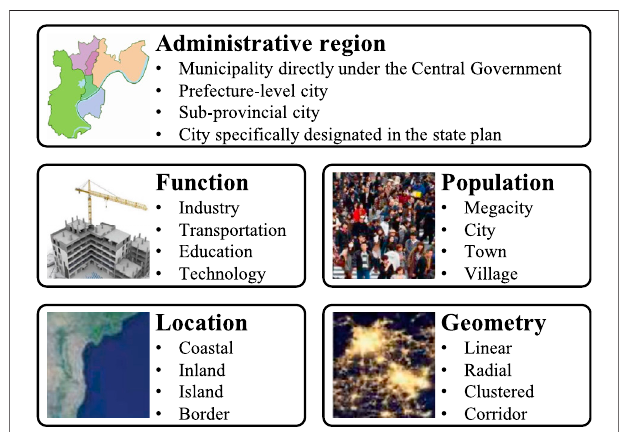
FIGURE 1 | Examples of classifying cities from different